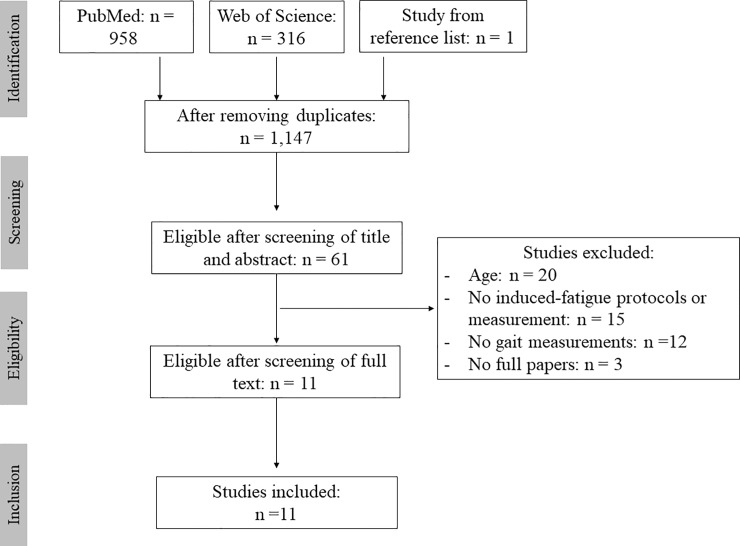
PRISMA flow diagram.